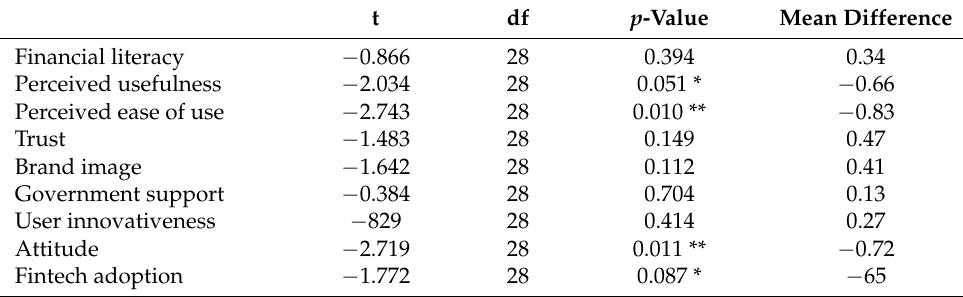
Table 17. Independent sample t -test result comparing Gender